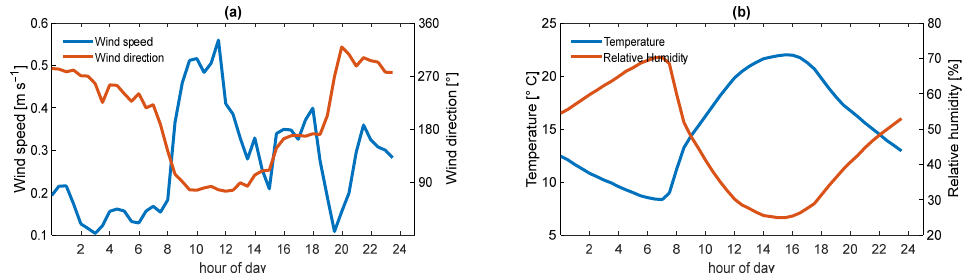
Figure 1. Meteorology. Average diurnal profile of ( a ) wind speed and direction, ( b ) temperature and relative humidity.